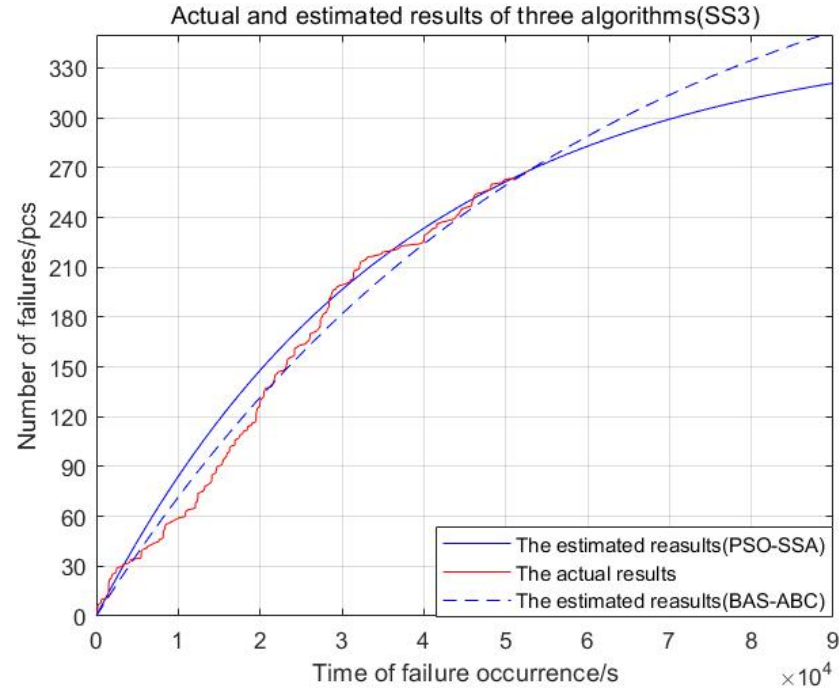
Figure 19. Actual and estimated results of two algorithms (SS3).